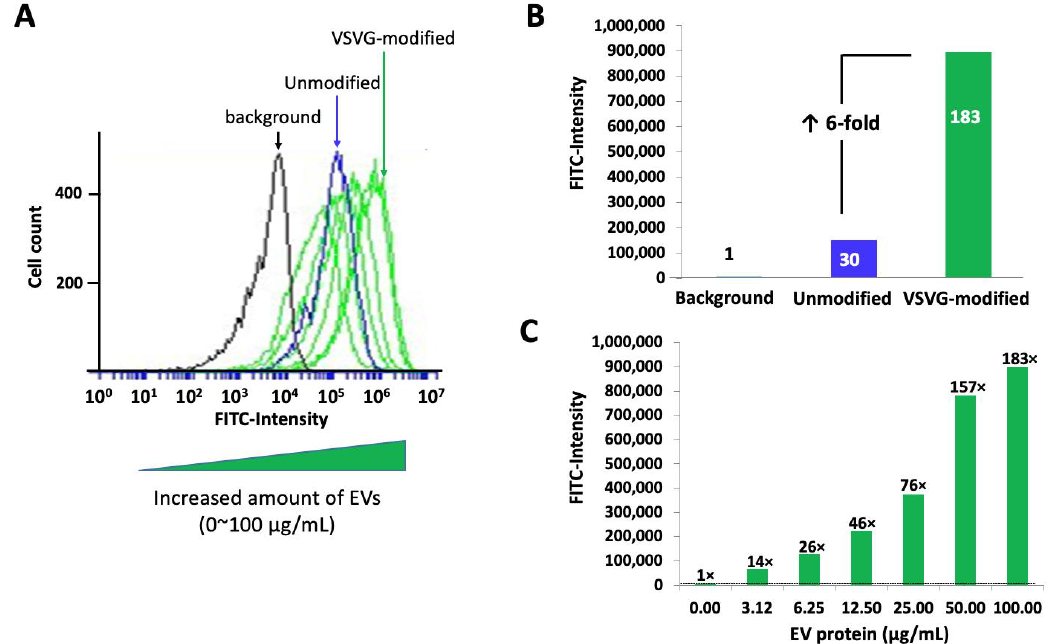
Figure 8. VSVG-GFP-modified EVs dramatically increase the cellular uptake by recipient cells. EVs prepared from the conditioned medium of either VSVG-GFP-modified cells or non-modified con- trols were chemically stained by Exoflow before being added to the culture medium of human 293T cells. The cells were treated for 24 h with increased concentrations of EVs (3.12 – 100 EV protein/mL), then washed, collected, and subjected to flow cytometry analysis as described in Materials and Methods. The amount of EV uptake was analyzed and graphed with CFlow Plus software. ( A ) A dose-response curve of VSVG-modified EVs compared to the control. The cellular uptake of VSVG- modified EVs (green) dramatically increased (shift to the right) compared to the non-modified con- trol (blue) at the same EV concentration (100 μg of protein/mL) and the background (black). ( B ) A bar-graph representation of the relative uptake efficiency of VSVG-GFP-modified (green) vs. non- modified control (blue) vs. the background (black). ( C ) A bar-graph representation of increasing cellular uptake of VSVG-modified EVs in a dose range of 0- 100 μg EV protein/mL. 4. Discussion The long-term goal of these studies is to optimize the design and engineering of EVs as living vehicles for the delivery of therapeutic biologics [44,57 – 59]. In particular, we aimed to characterize the properties of EVs harboring different molecular scaffolds that can be engineered for specific tissue targeting and uptake by recipient cells. In engineering EVs for clinical applications, it will be essential to establish how specific molecular scaf- folds impact the physicochemical and biological phenotypes of modified EVs. Ultimately, this knowledge will help narrow the types of transmembrane scaffolds that are suitable for EV-based therapies [60,61]. In the present study, we employed state-of-the-art high- throughput, on-chip assays to examine how different scaffolds affect the engineering effi- ciency, physical properties, and biological responses of engineered EVs [39,41,60,62,63]. We found that the endogenous tetraspanin scaffolds (CD9, CD63, and CD81) were incor- porated into distinct subpopulations of EVs, whereas VSVG was found equally in all EV subtypes. We also established that EVs bearing molecular scaffolds increased their aver- age diameter compared to unmodified EVs. Although we do not know the exact mecha- nisms accounting for the increased size of the engineered EVs, we speculate the following